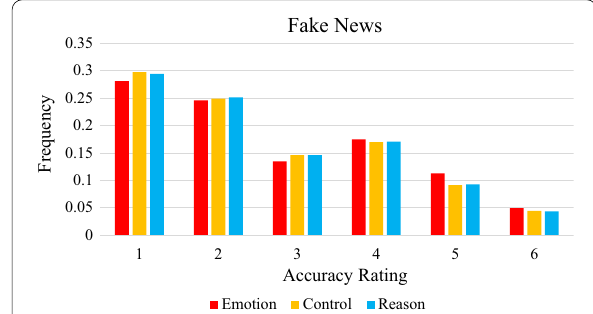
Fig. 4 Higher accuracy ratings were more frequently given to fake news headlines in the emotion condition compared to the control and reason conditions